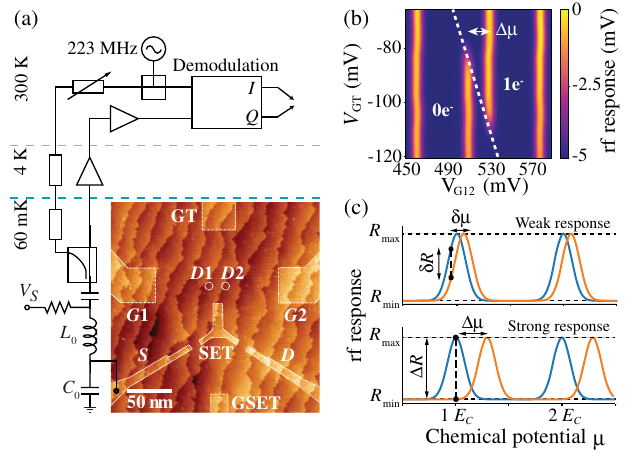
FIG. 1. Strong response of a donor-based rf SET. (a) STM image of the device with external reflectometry circuit schematic.